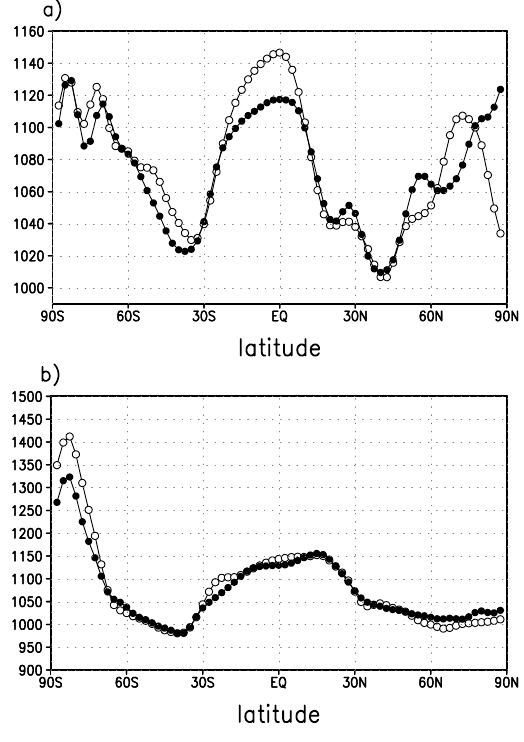
Fig. 12. Same as Fig. 10 but for the Brunt-Vaisalla